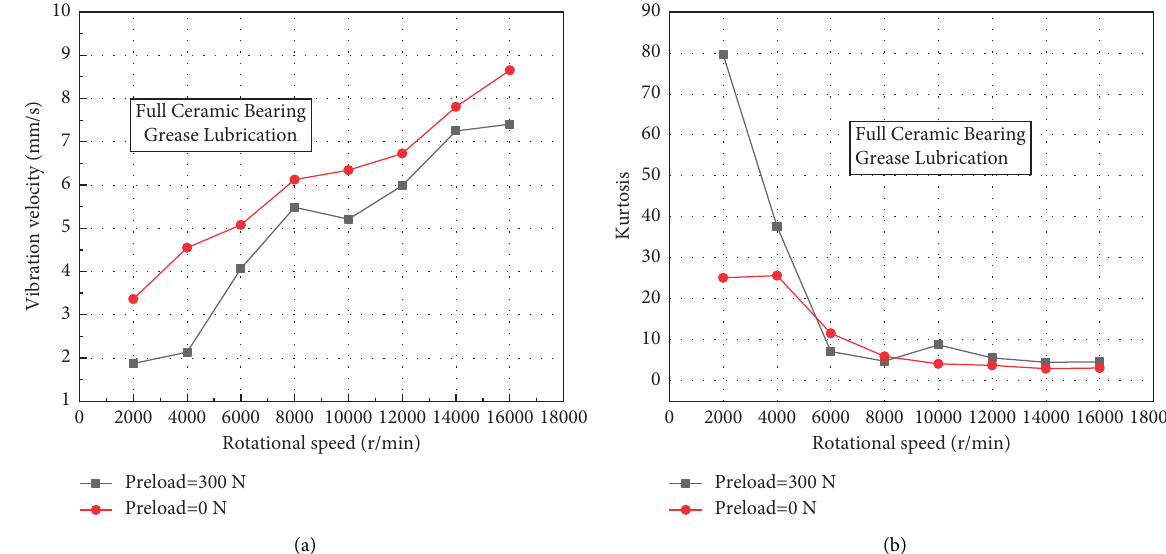
Figure 6: Variation of vibration velocity and kurtosis for Si velocity. (b) Kurtosis.